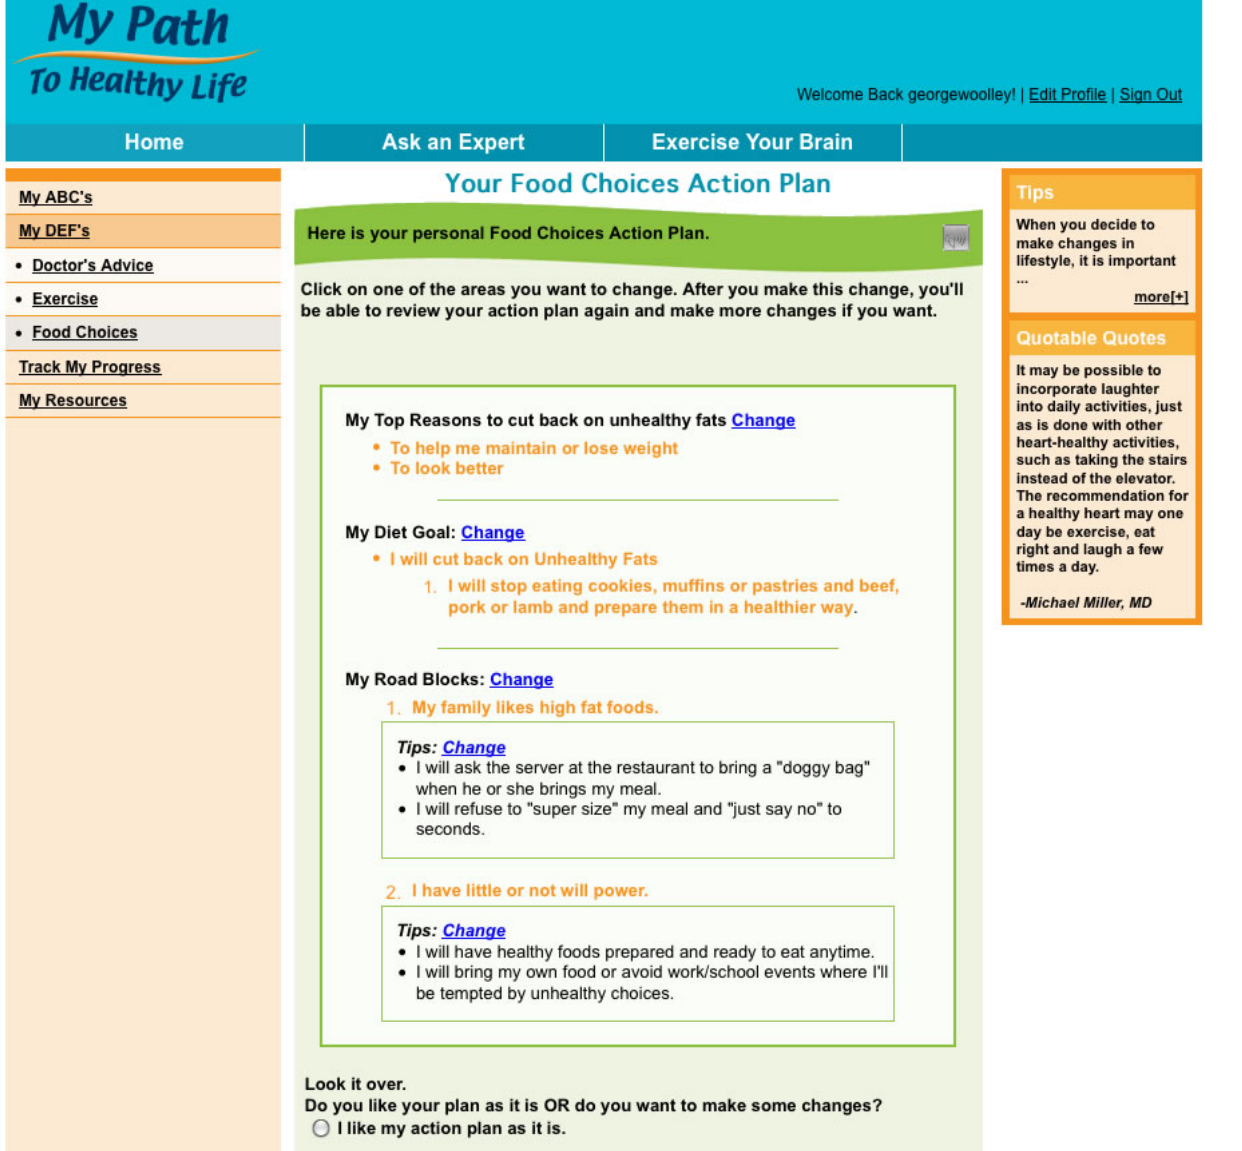
Figure 2. Your food choices action